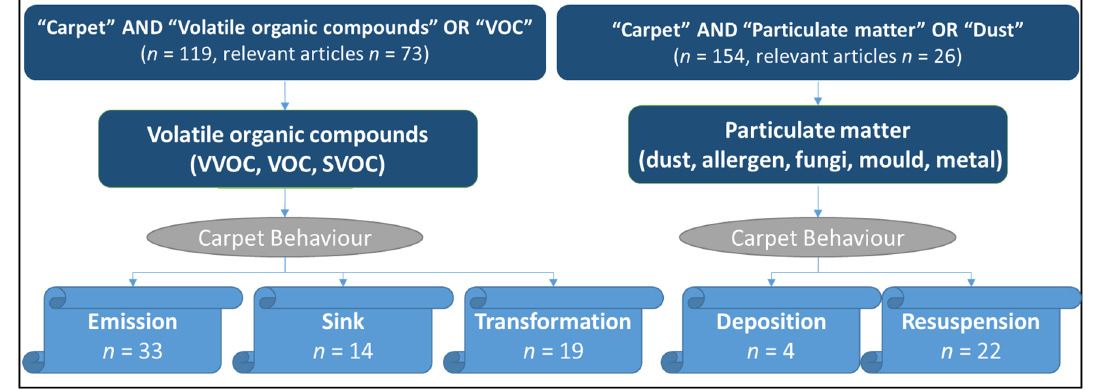
Figure 1. Keywords used for collecting literature and the number of relevant articles.